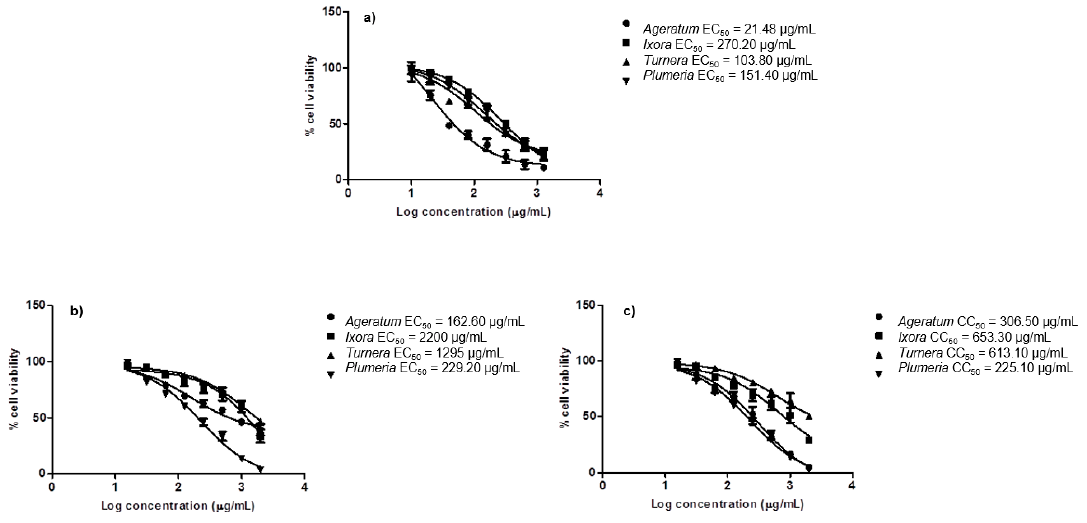
Figure 6. The drug dose-dependent curves of four top active extracts against ( a ) 4T1, ( b ) T47D, and ( c ) Vero cells.